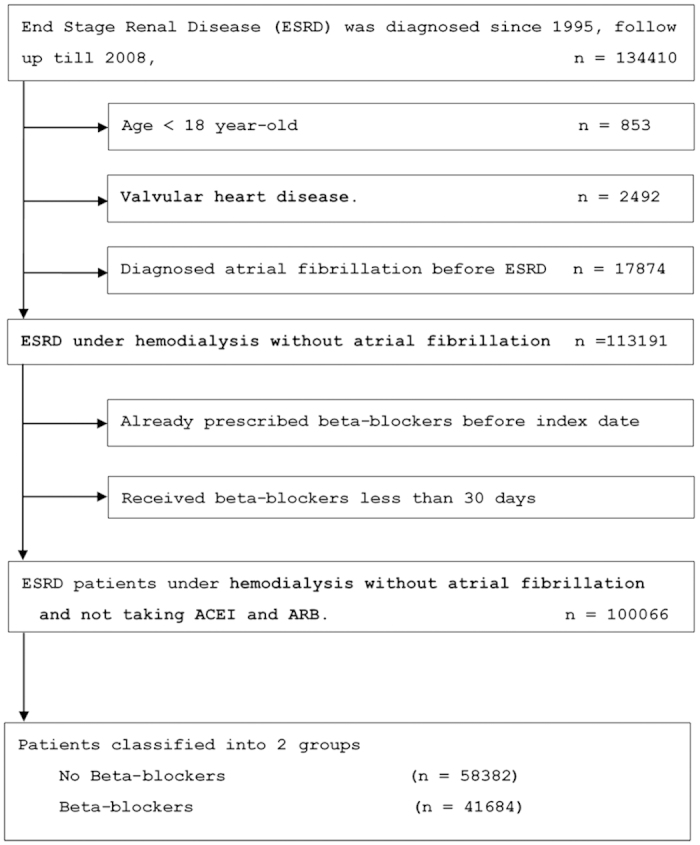
Patient flow diagram.